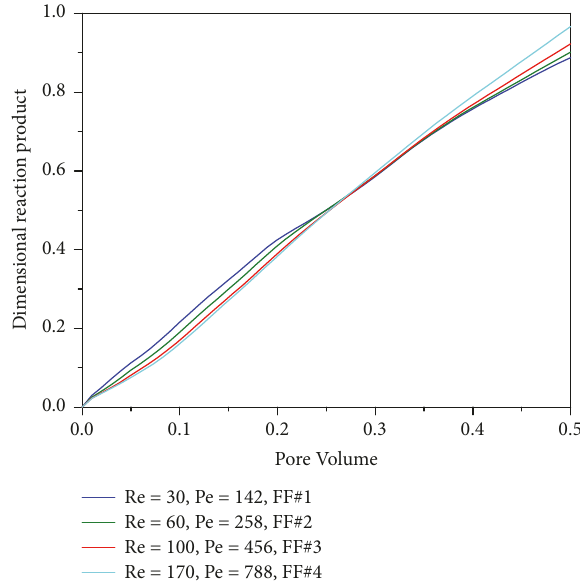
Figure8:Thetemporalevolutionofdilutionindexofthecompound A for the nonreaction transport under the different flow fields in the single self-affine fracture with Hurst exponent of 0.8.